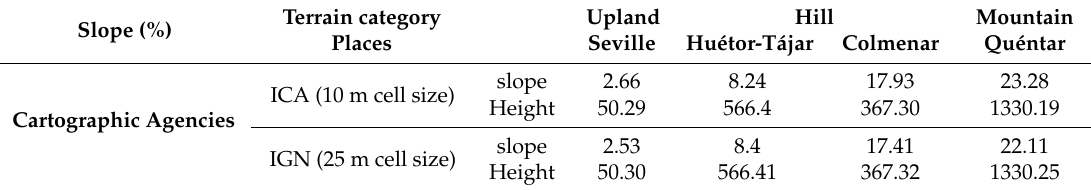
Table 1. Slopes (%), heights (m) and category for each DEM from the dataset. Terrain category Upland Hill Mountain Slope (%) Places Seville Huétor-Tájar Colmenar Quéntar ICA (10 m cell size) Cartographic Agencies